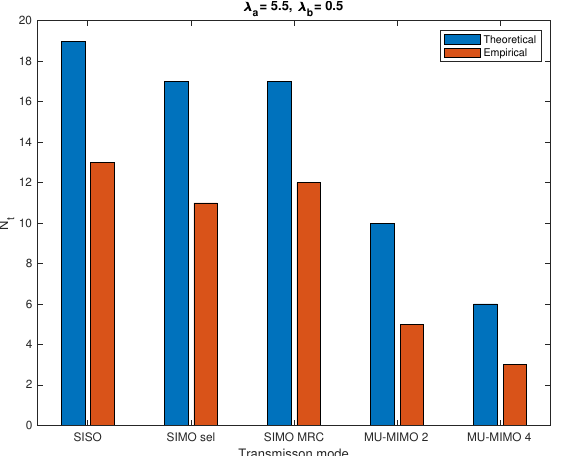
Figure 9. Comparison between theoretical and empirical N t values in which λ a = 5.5 nodes/km 2 and λ b = 0.5 nodes/km 2 .